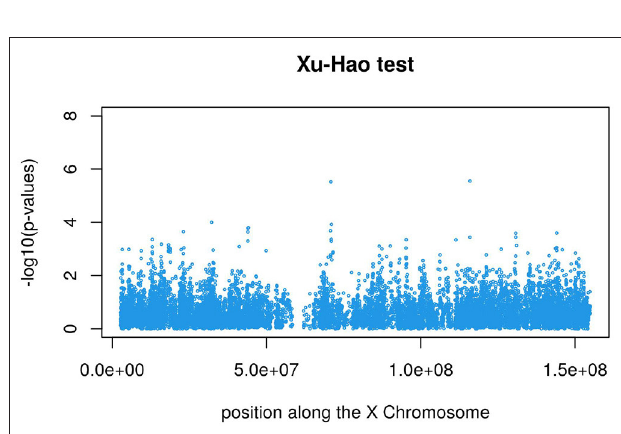
FIGURE 6 | Manhattan plot of X Chromosome genome-wide association results-Cox-XCE test.